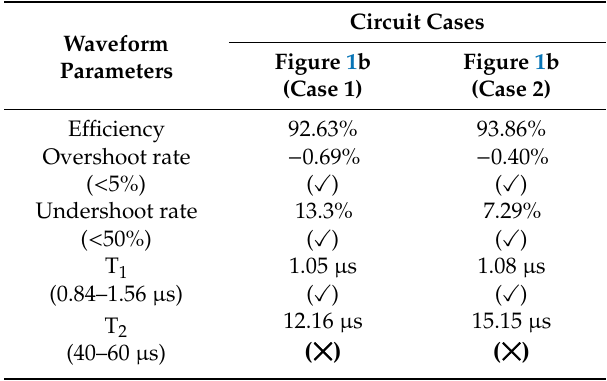
✓ indicates the parameters being in accordance with the standard requirement [4,5]; ✕ indicates the parameters not being in accordance with the standard requirement [4,5].